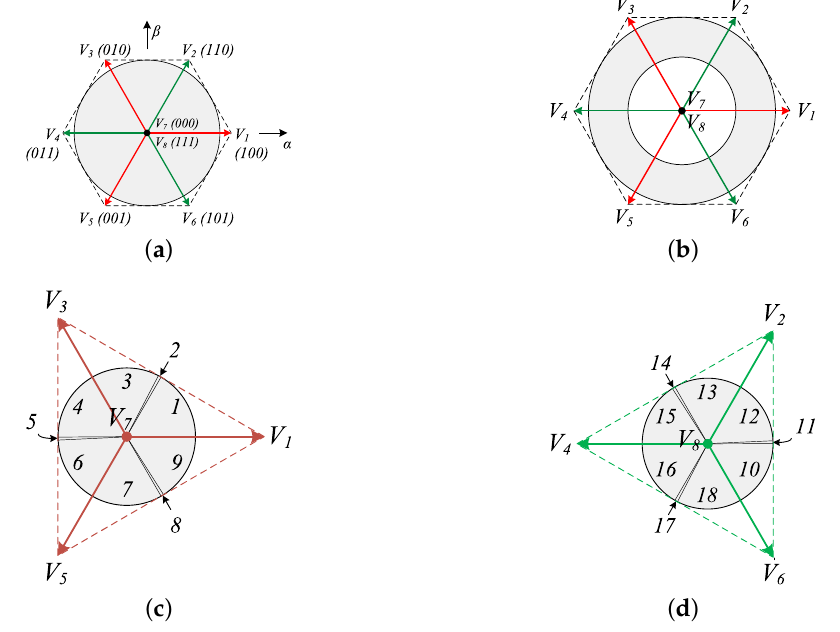
Figure 7. αβ plane space vector diagrams. Odd vectors (red), even vectors (green). ( a ) SV vectors. ( b ) Modulation index region where SVPWM is used ( 0.5 ≤ m < and modulation zone numbers for odd CCMV SVM. ( d ) Feasability region ( m < 0.5 ) and modulation zone numbers for even CCMV